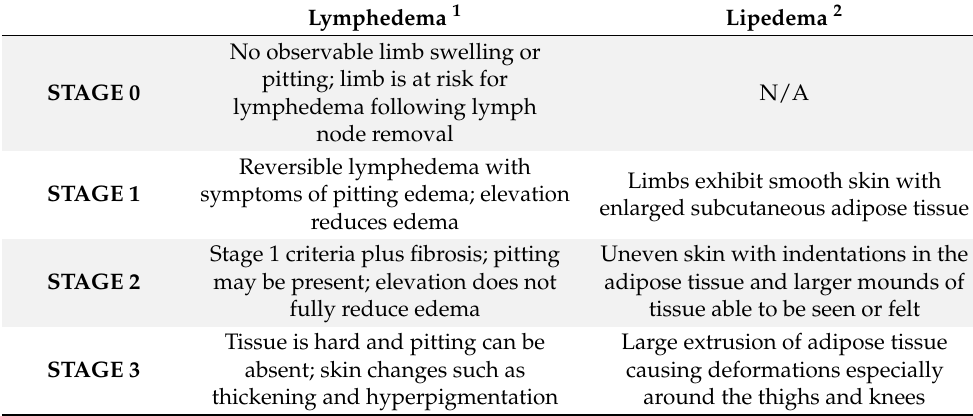
Table 1. Clinical criteria for lymphedema and lipedema staging by